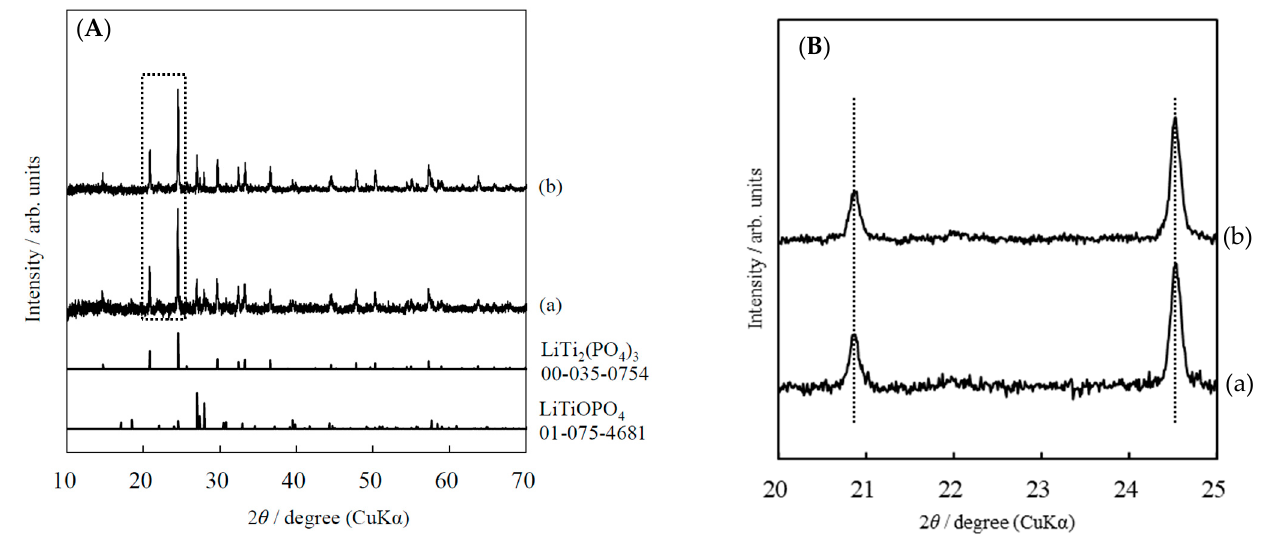
Figure 2. ( A ) XRD patterns of a LATP electrolyte sheets (a) calcined at 650 ◦ C (porous) and (b) CSP with H 2 O 30 wt% at 200 ◦ C for 30 min. ( B ) The enlarged XRD patterns of a LATP electrolyte sheets (a) calcined at 650 ◦ C (porous) and (b) CSP with H 2 O 30 wt% at 200 ◦ C for 30 min from 20 to 25 ◦ .